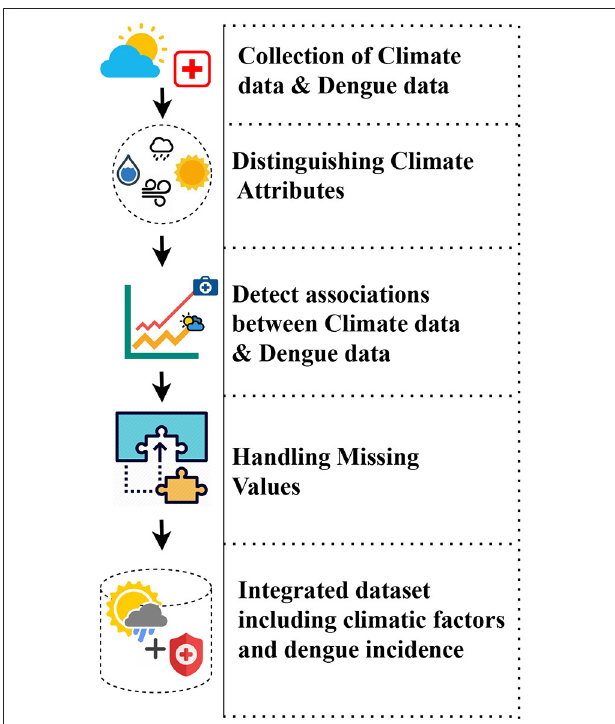
FIGURE 6 | Data pre-processing